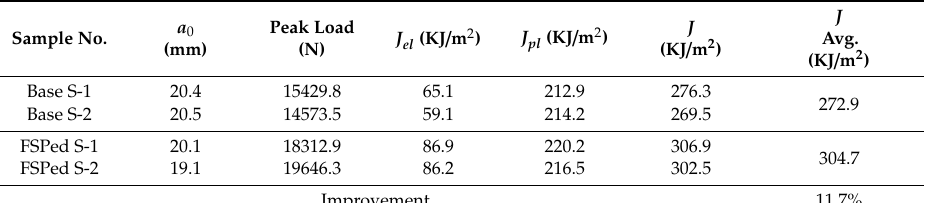
Figure 14. Load–crack opening displacement (COD) curves of BM and FSPed 2507 SDSS. Figure 14. Load--crack opening displacement (COD) curves of BM and FSPed 2507 SDSS. Table 5. Influence of FSP on the fracture toughness of 2507 SDSS.